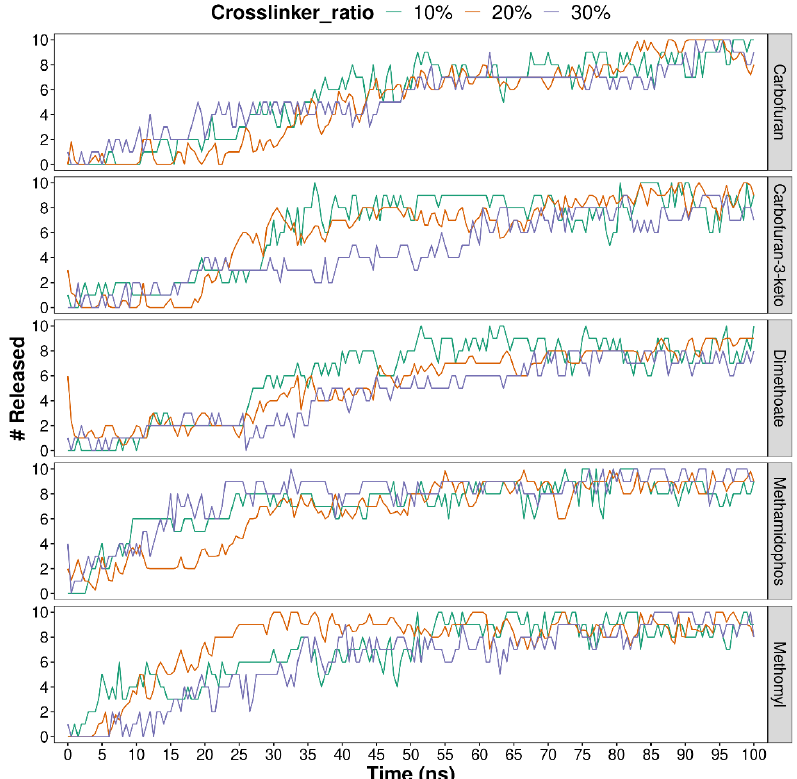
Figure 3. Number of pesticides released from PVA-MA hydrogels, during the 100 ns of molecular dynamics simulations. A total of 3 crosslinker ratios were considered. The release of pesticides was calculated during the simulation by counting, in each step, the pesticide molecules located more than 5 Å away from the hydrogel.